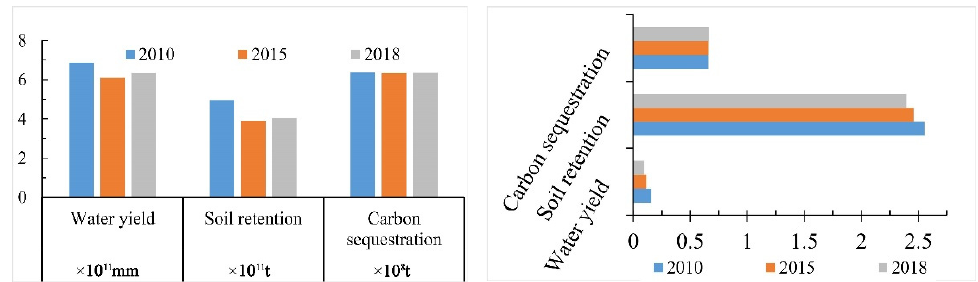
Figure 3. Total ecosystem services and coefficient of variation of ecosystem services.